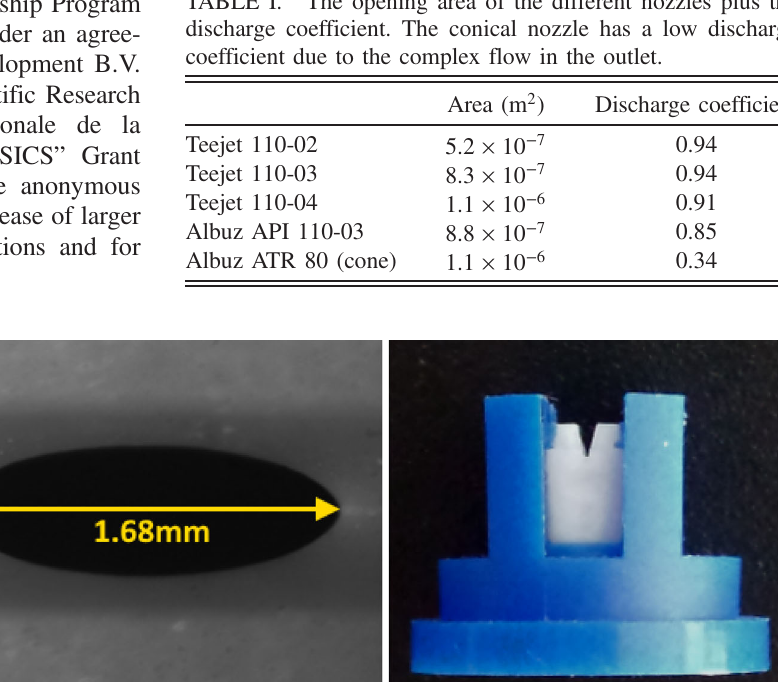
FIG. 12. A picture of the Teejet 110-03 nozzle seen from above, with a magnification of the elliptical opening, plus a side view. This nozzle produces a flat liquid sheet.